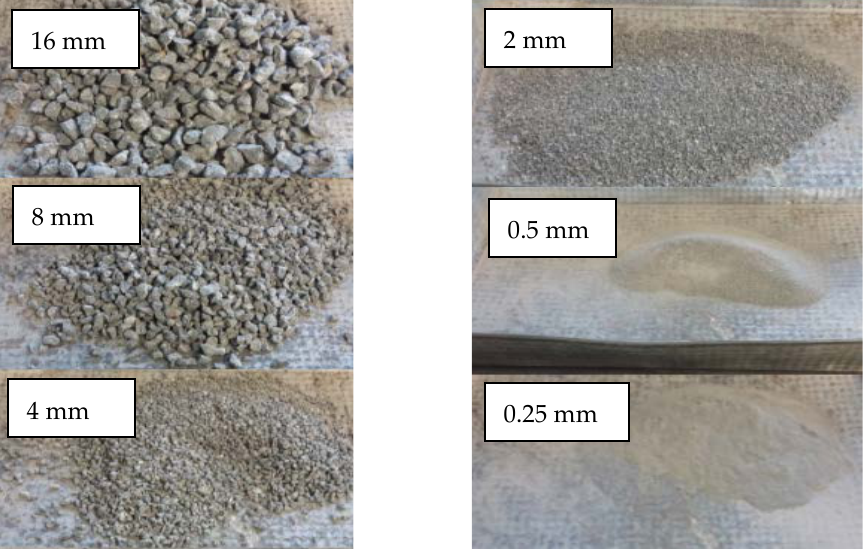
Figure 3. The individual fractions of the recycled coarse aggregates after sieving.